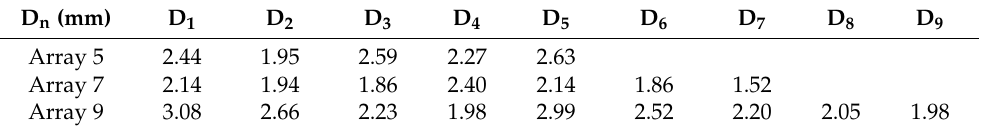
Table 2. Final optimized distances D n between elements in the array with 5, 7, and 9 elements.